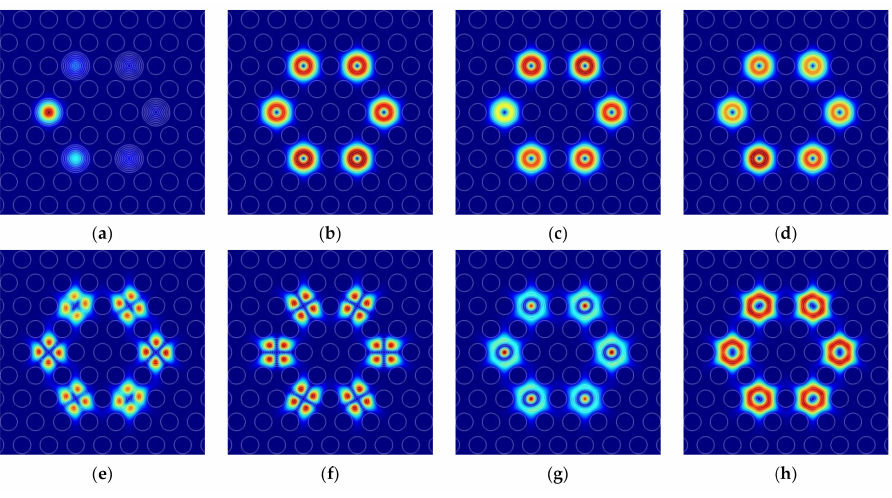
Figure 8. Computed radial mode field distributions of eight guided polarization modes, propagating without cutoff, in the selected six-core-MOF: ( a ) LP 01 -like; ( b – d ) LP 11 -like; ( e , f ) LP 21 -like; ( g ) LP 02 -like; ( h ) LP 31